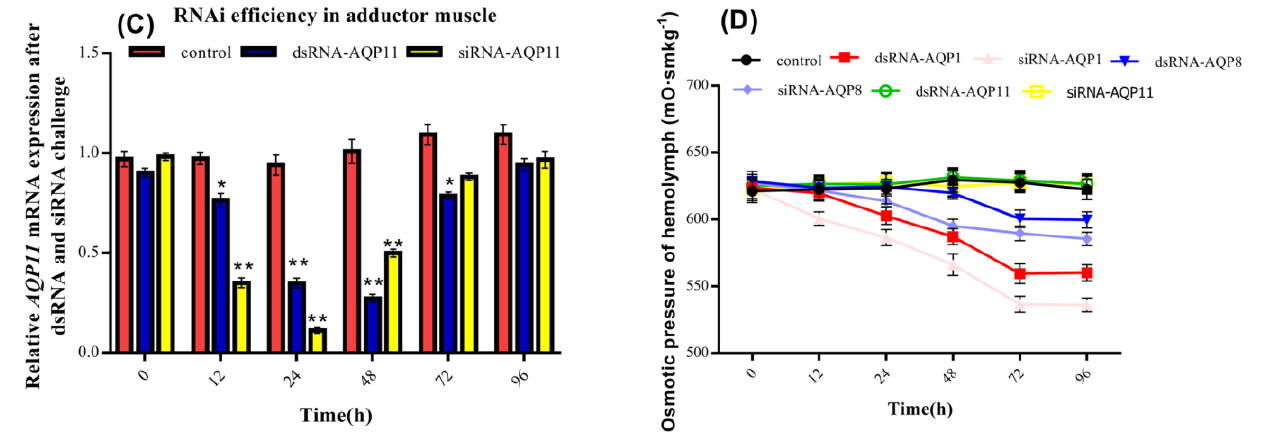
Figure 8. Relative expression levels of Sc-AQP1 ( A ), Sc-AQP8 ( B ), and Sc-AQP11 ( C ) and osmotic pressure changes ( D ) in S. constricta post-injection with DEPC-treated water and corresponding dsRNA and siRNA. Vertical bars represent the mean ± SE ( n = 5). Data were statistically analyzed by using one-way ANOVA, followed by the LSD test. The asterisks (*) show a significant difference between the RNA interference group (dsRNA and siRNA) and the control group at each sampling time. Note: * p < 0.05; ** p < 0.01.